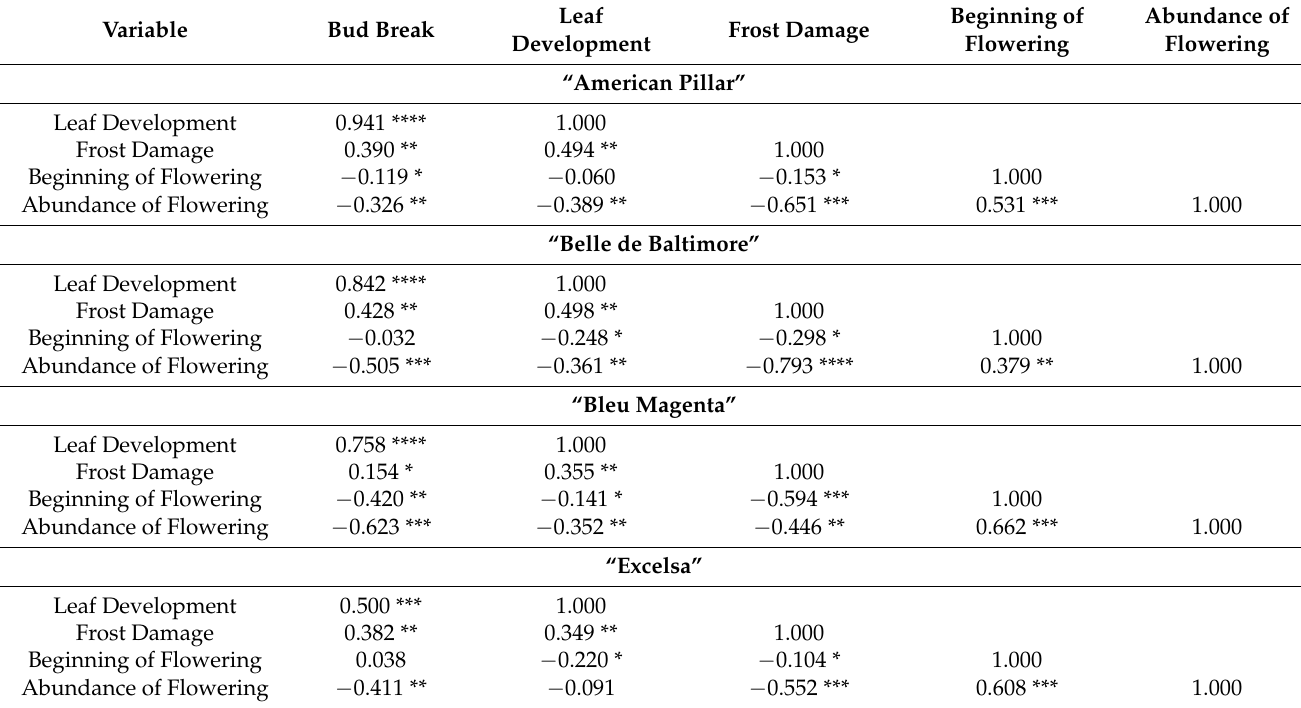
Table 8. Correlation matrices between frost damage, early phenology stages, beginning of flowering, and its abundance for “American Pillar”, “Belle Herminie”, “Bleu Magenta”, “Excelsa”, “Kew Rambler”, “Lykkefund”, “Maria Lisa”, and “Paul’s Himalayan